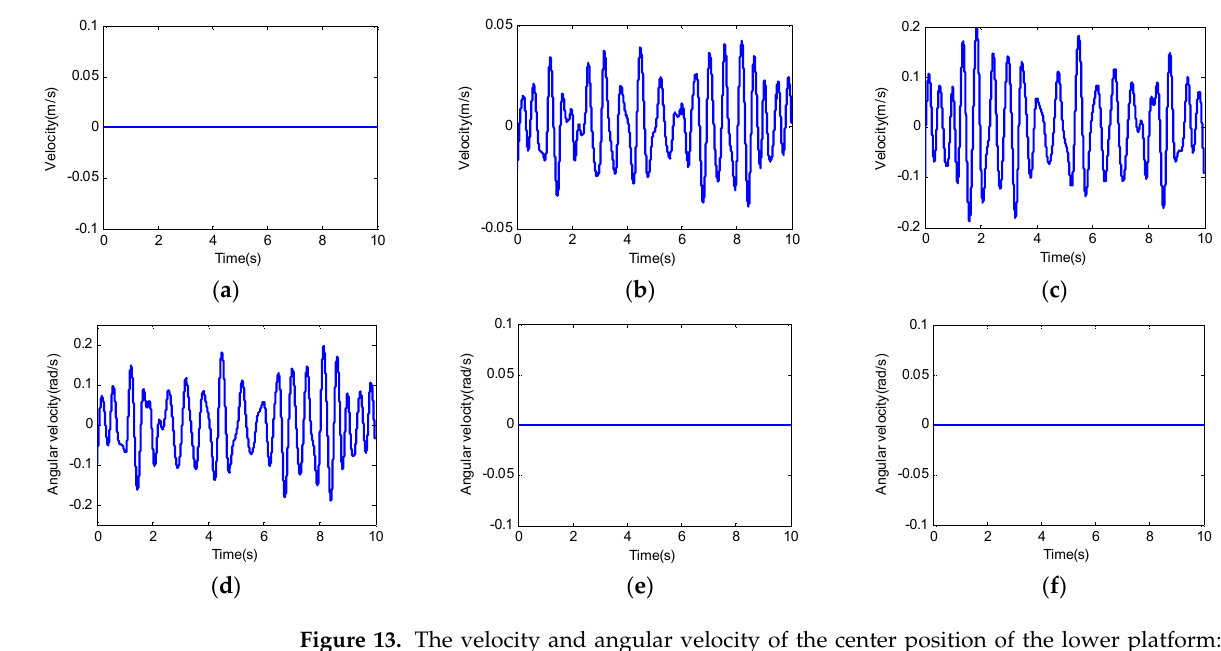
Figure 13. The velocity and angular velocity of the center position of the lower platform: ( a ) x -axis displacement; ( b ) y -axis displacement; ( c ) z -axis displacement; ( d ) rotation around the x -axis; ( e ) rotation around the y -axis; ( f ) rotation around the z -axis.